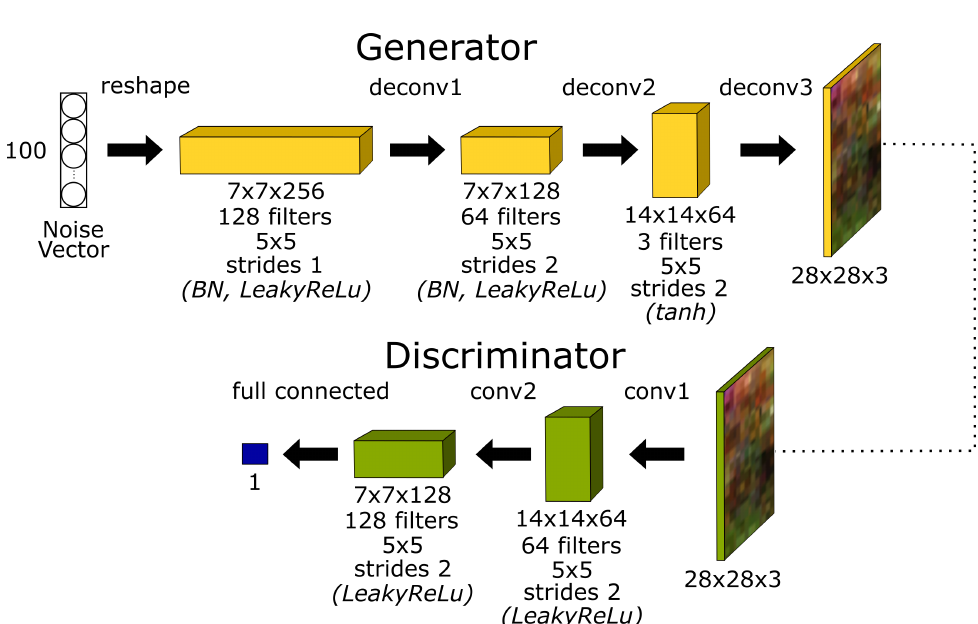
Figure 1. Deep Convolutional Generative Adversarial Network (DCGAN) structure with data flow.